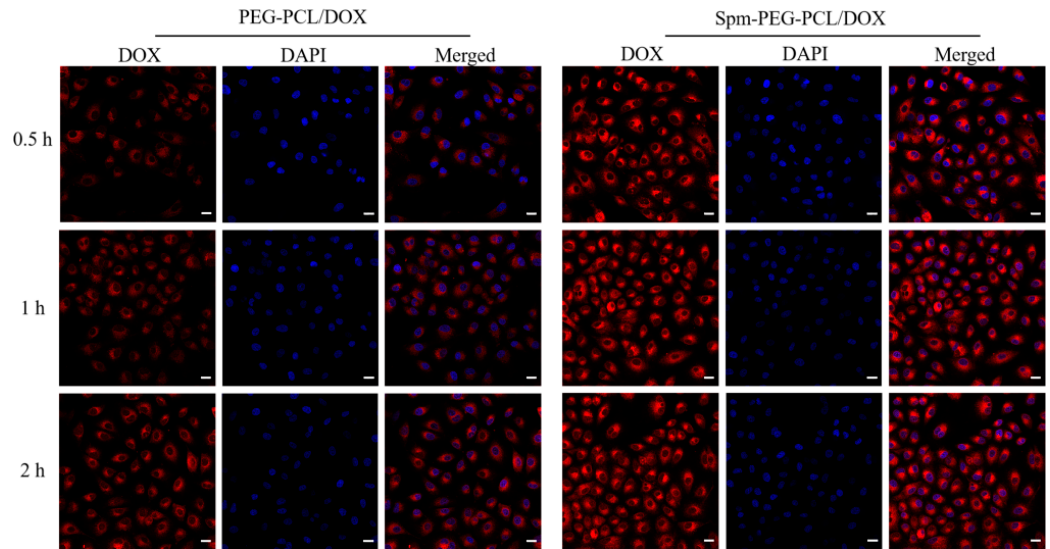
Figure 8. Cellular uptake of Spm-PEG-PCL/DOX and PEG-PCL/DOX micelles observed by CLSM. DOX (red) was used to label micelles, DAPI (blue) was used to stain nuclei, and the scale bar is 20 μ m.